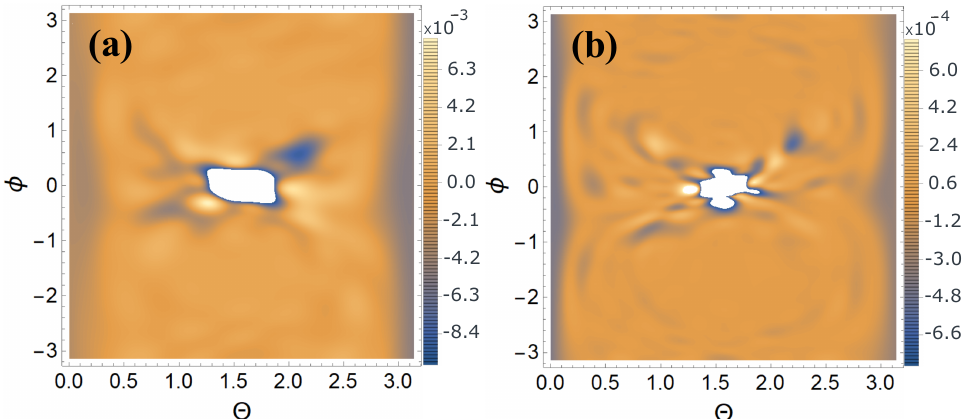
Figure 4. The figures show the contribution to the scattering spectra of a diamond lattice with one NV centre (the δ parameter above is calculated) as 2D contour plots: ( a ) the diamond unit cell with NV centre (see Figure 1a), ( b ) this on the diamond structure presented in Figure 1b. The calculation was done using Equation (3). The angles θ and φ are represented in a spherical coordinate system, where the z axis is directed upwards and y is in the direction of the incident